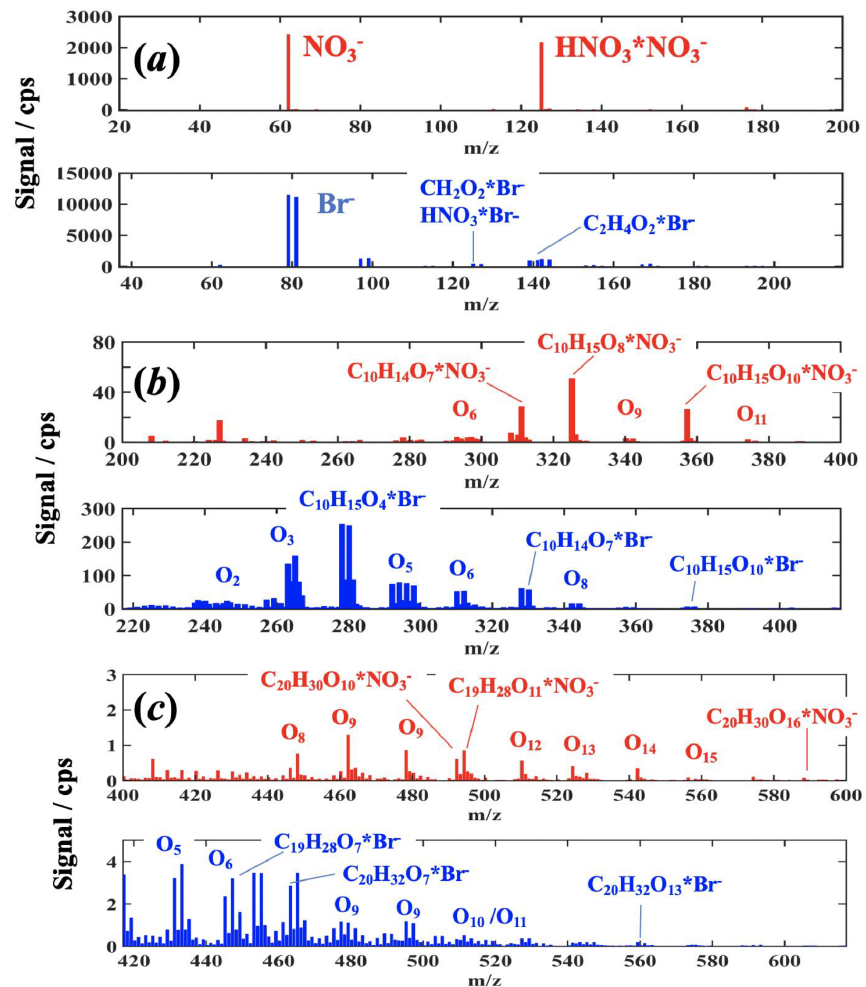
Figure 4. Example MION spectra of organic oxidation products obtained from α -pinene ozonolysis experiments shown with a common product mass axis for both ion modes, i.e., the Br − spectrum (blue) is displaced by 17Th (difference between reagent ion Br − and NO − masses) to overlap the same composition products horizontally. (a) Illustrates the reagent ion spectra, (b) the monomer range (i.e., oxidation products which have the same number or less carbon atoms), and (c) the dimer range (i.e., oxidation products with about two times the carbon number of α -pinene), respectively. For a few most prominent products the explicit compositions are given, whereas for most of the detected peak groups only the average number of oxygen atoms is indicated; in dimer range the products with adjacent number of carbon and oxygen atoms start to